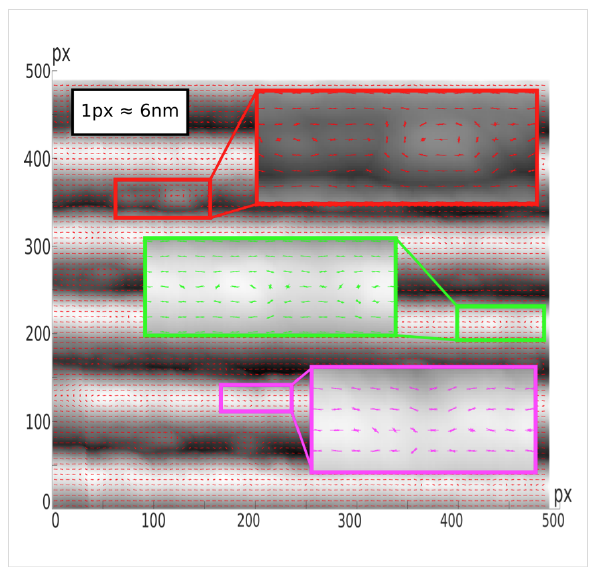
Figure 7: Evaluation of HOG histograms. The example shows a 500 × 500 pixels (about 3 × 3 µm) fragment of an AFM image of a copy of the blazed grating master. Blocks gathering 6 × 6 pixels show the gradients. These are eventually employed to compute the histograms.